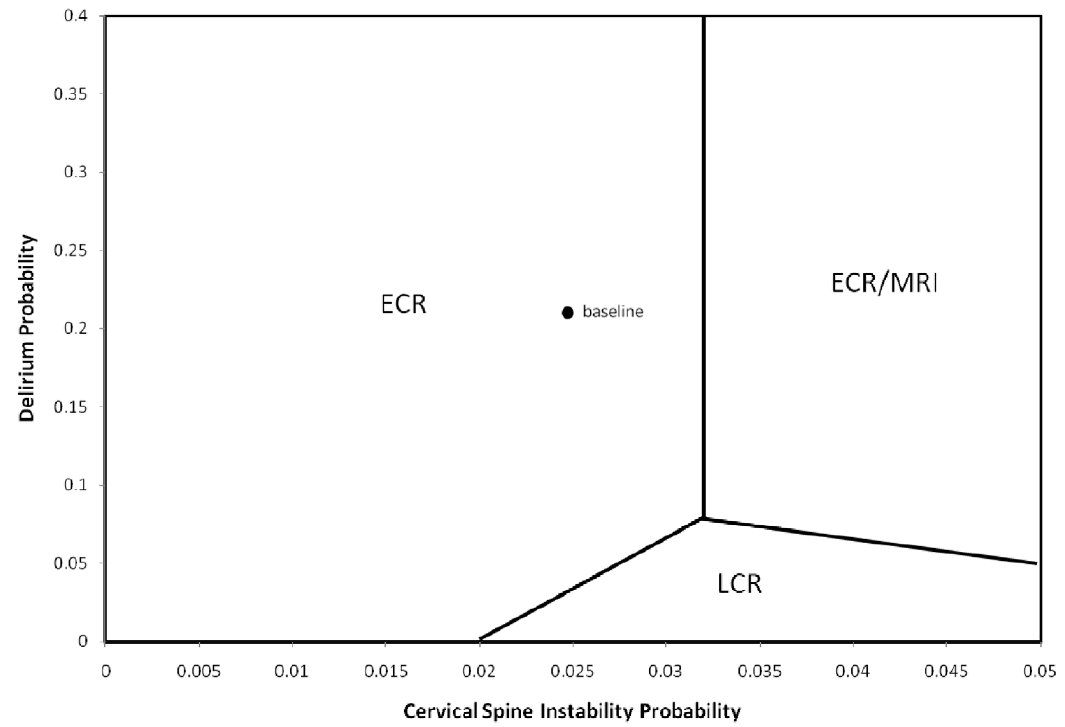
Figure 2. Two-Way Sensitivity Analysis, Delirium Probability vs. Cervical Spine Instability Probability in the Stable category of TBI.